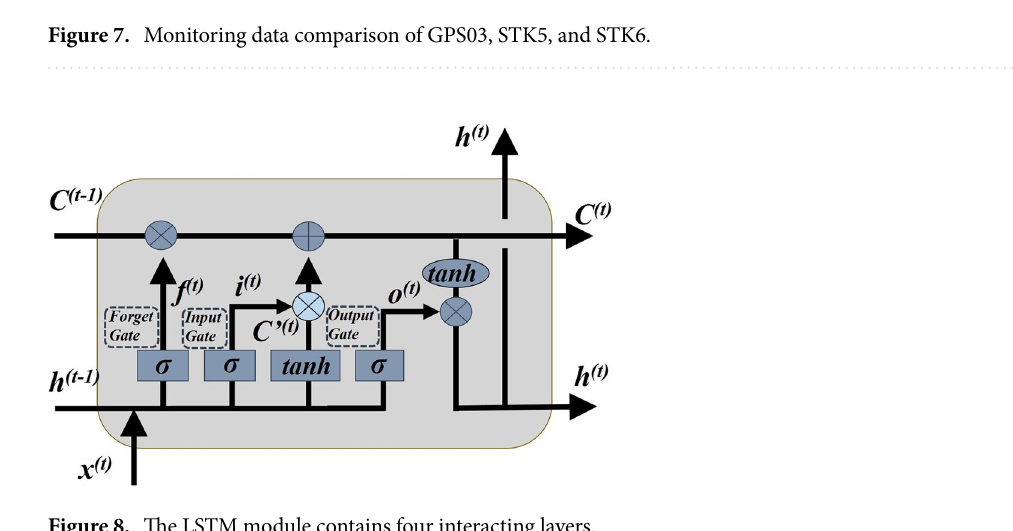
Figure 8. The LSTM module contains four interacting